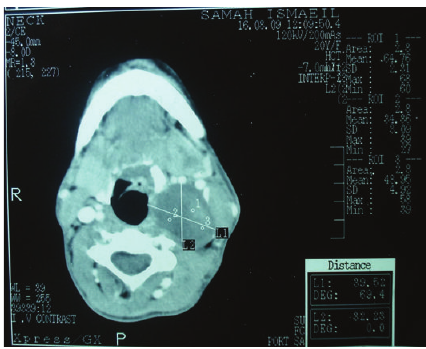
Figure 1: Axial view of CT showing dimensions of the tumor.